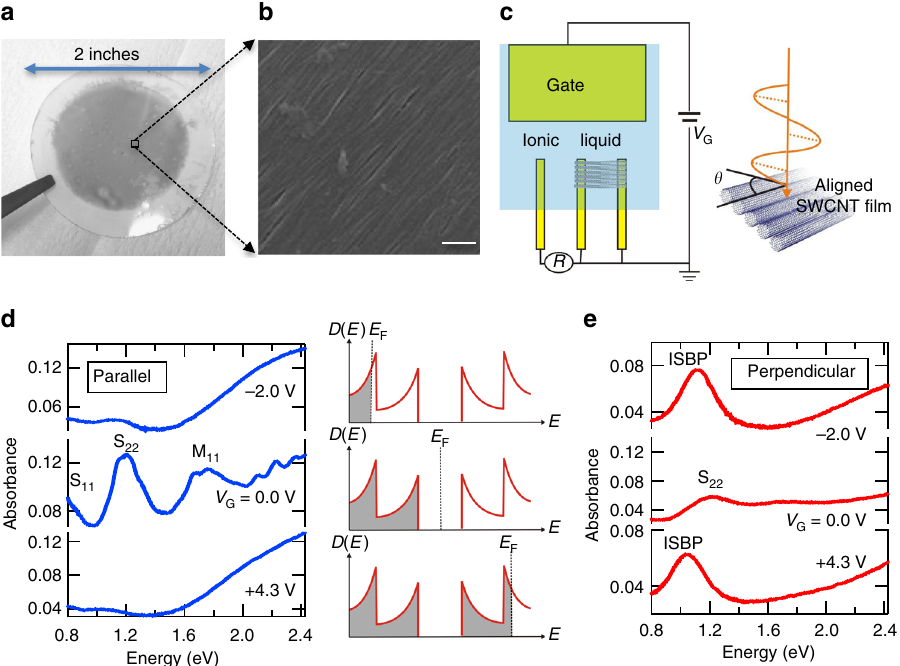
Fig. 2 Appearance of the intersubband plasmon (ISBP) peak in a gated and aligned carbon nanotube fi lm in polarized absorption spectra. a Optical and b scanning electron microscopy images of an aligned SWCNT fi lm. The white horizontal bar in a represents a length of 100 nm. c Schematic diagram for the setup for the polarization-dependent absorption spectroscopy experiments on an aligned SWCNT fi lm gated through electrolyte gating. V G : gate voltage, R : reference voltage. d Parallel-polarization and e perpendicular-polarization optical absorption spectra at different gate voltages for an aligned SWCNT fi lm containing semiconducting and metallic nanotubes with an average diameter of 1.4 nm. The ISBP peak appears only for perpendicular polarization ( e ) for both electron and hole doping, corresponding to V G = − 2.0 and 4.3 V,